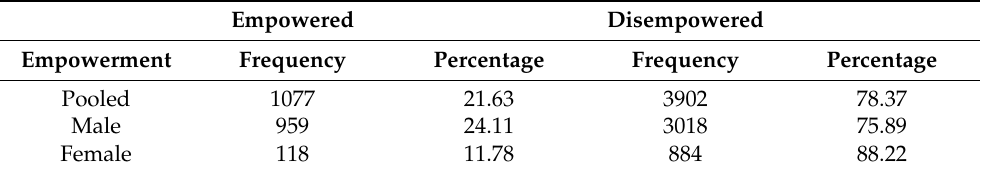
Table 5. Distribution of empowered households by